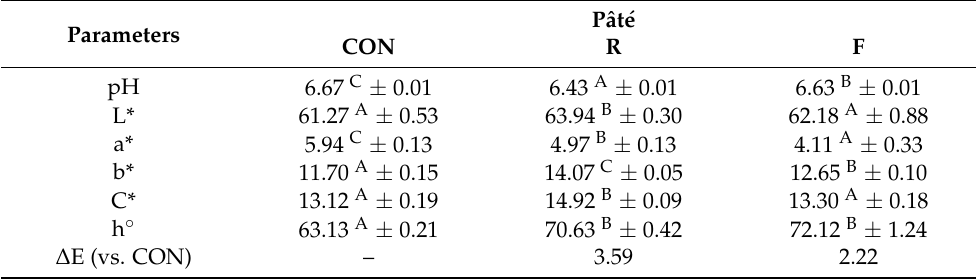
Table 2. Physicochemical properties of pork p â t é s (mean ± s.d.).